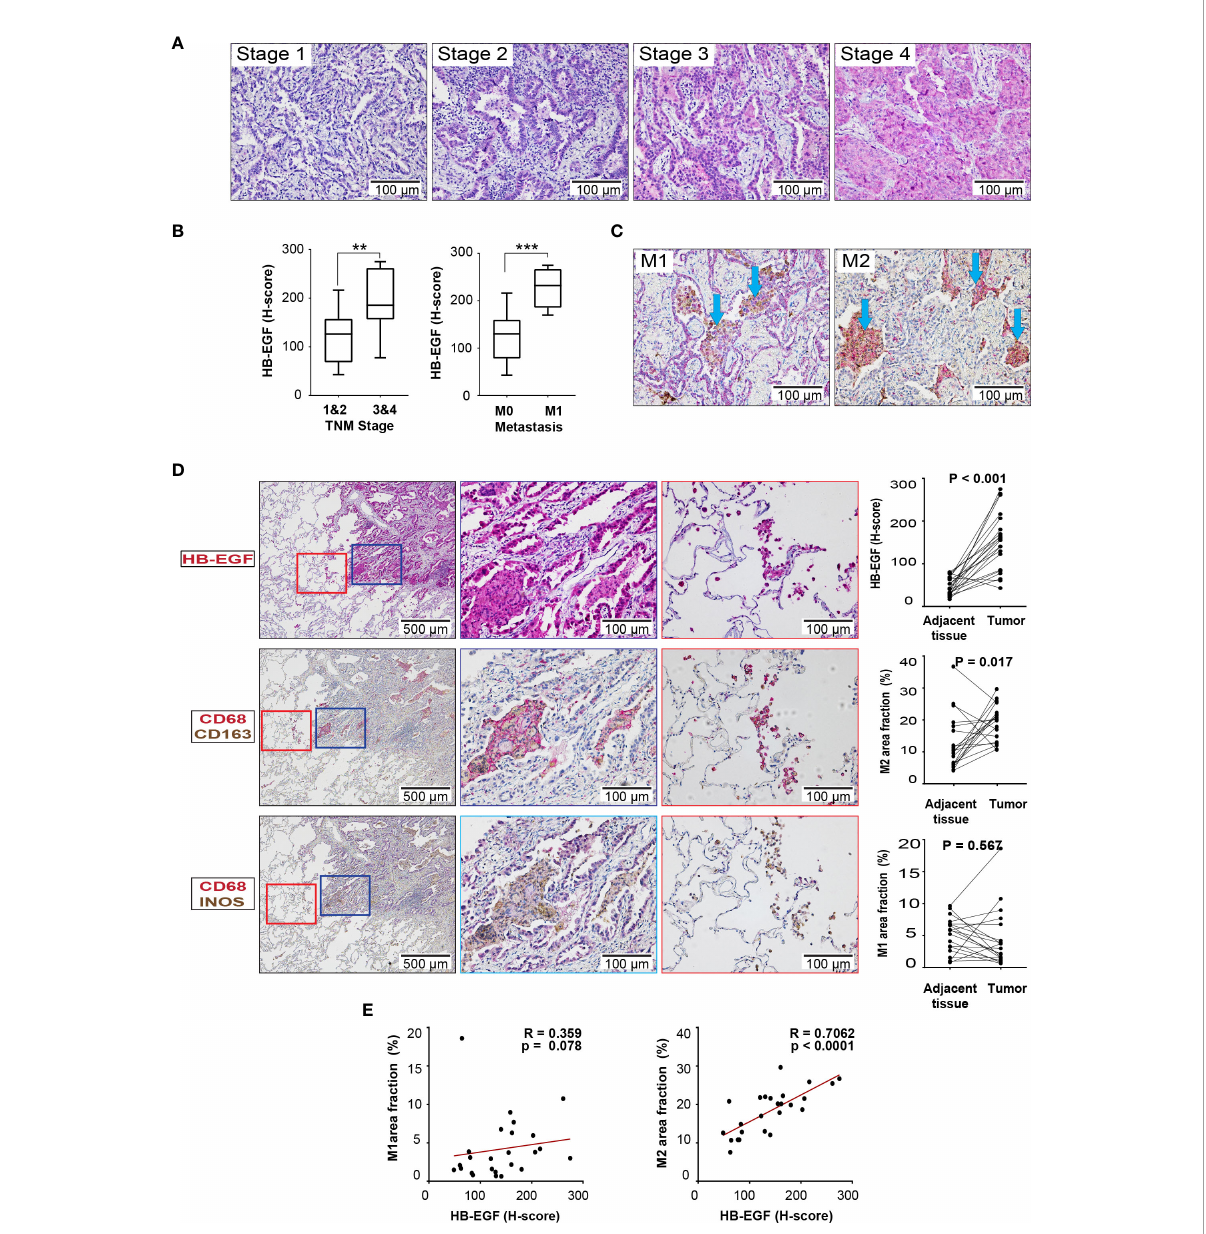
FIGURE 6 HB-EGF is highly expressed in lung cancer and positively correlated with M2 macrophages in LUAD: (A) Representative immunohistochemical images for HB-EGF in different stages of lung adenocarcinoma (magni fi cation, 200×). (B) Semiquantitative expression of HB-EGF by stage and metastasis status. The whisker shows the standard deviation, and the Wilcoxon rank-sum test was used. (C) Representative immunohistochemical images for macrophage M1 and M2 double positive in lung tumor (CD68 (brown) and iNOS (red) for M1; CD68 (brown) and CD163 (red) for M2, magni fi cation x20). (D) HB-EGF, M1, and M2 IHC images (magni fi cation, 5× and 20×) and quanti fi cation for lung cancer and adjacent lung tissues. The Wilcoxon signed-rank test was used. (E) The dot plot shows Spearman ’ s correlation between HB-EGF and